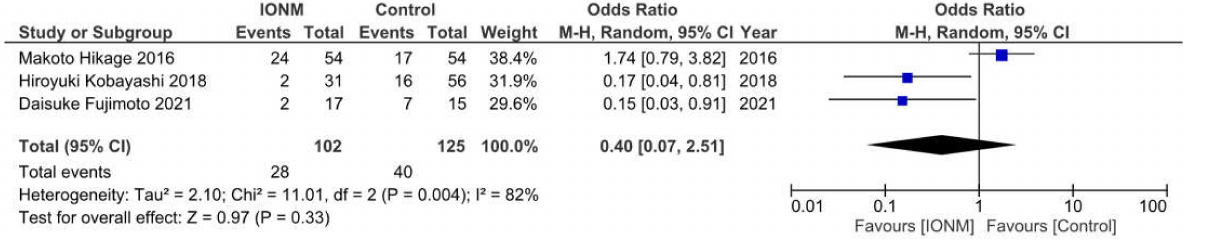
Figure 4. Forest plot of IONM for aspiration. Abbreviations: IONM—intraoperative neuromonitoring.